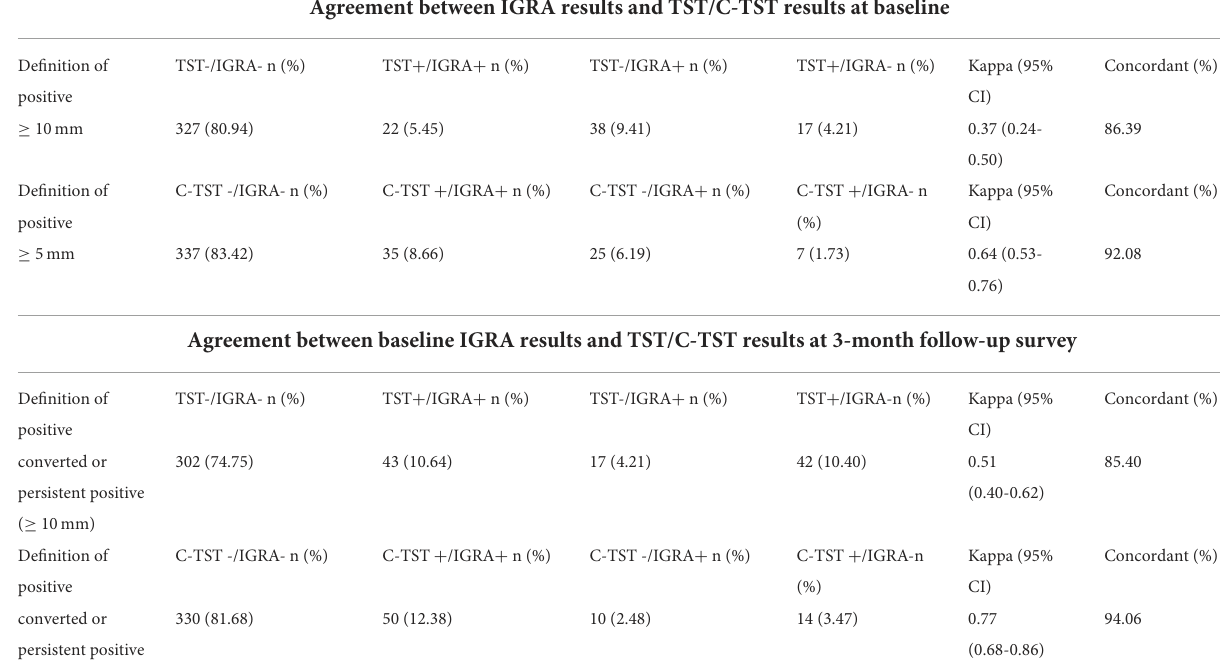
The level of FPG in the baseline positive and conversions groups of TST and C-TST were shown in Supplementary Figure 2. For TST, the median level of FPG in the baseline positive ( N = 39) and conversion ( N = 50) group was 7.74 mmol/L (IQR: 6.70–9.75) and 9.35 mmol/L (IQR: 7.02–12.64) ( p = 0.058), respectively. For C-TST, the median level of FPG in the baseline positive ( N = 42) and